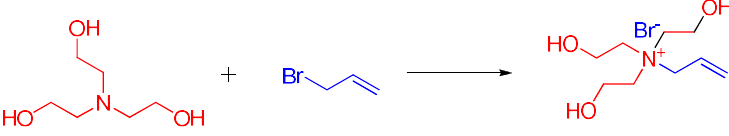
Figure 1. Synthesis route of tris hydroxyethyl allyl ammonium bromide (THAAB).